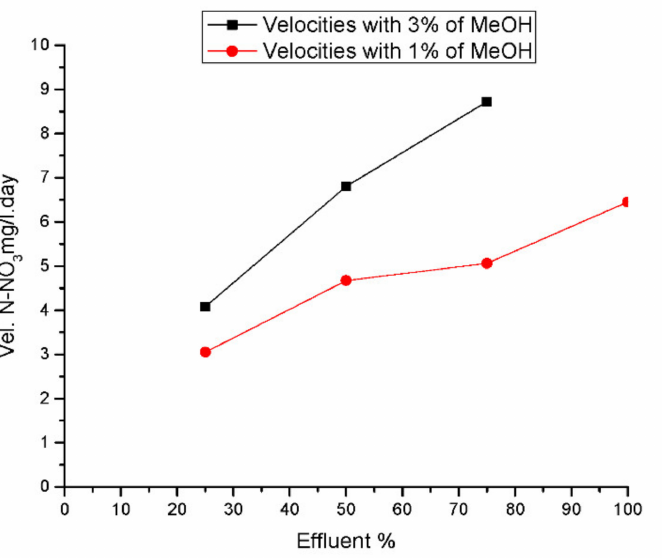
Figure 8. Denitrification velocities under methanol addition and different effluent